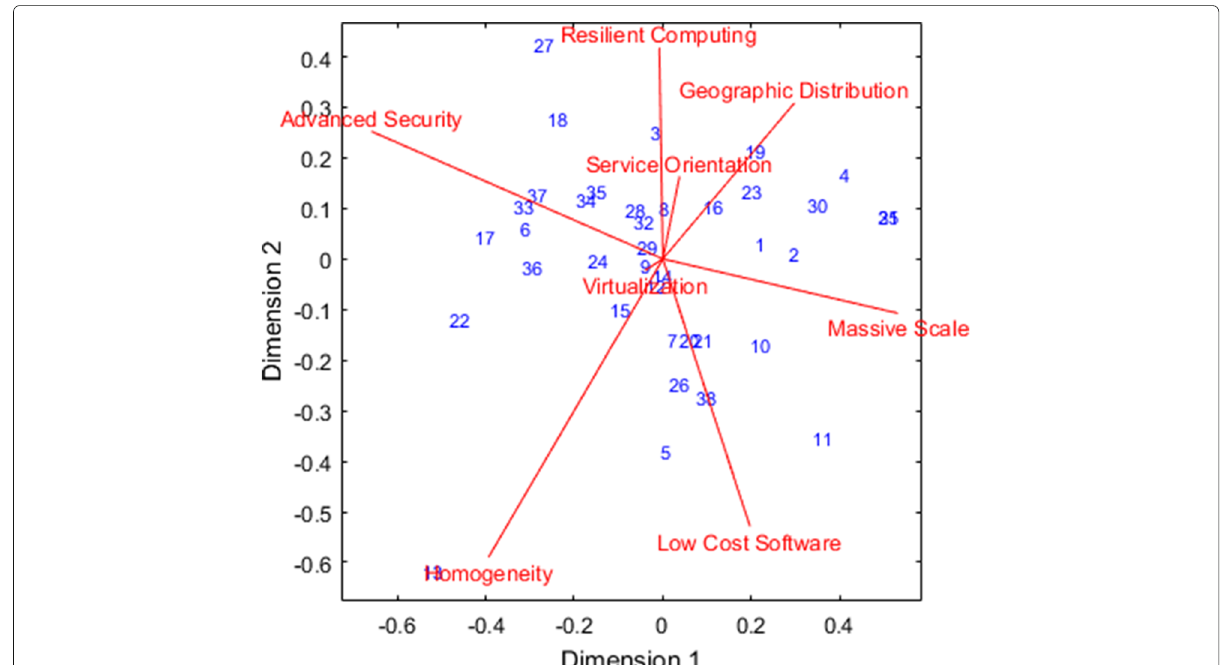
Fig. 8 2-dimensional biplot of the 8-dimensional partitioned dataset of the common characteristics. ServiceOrientation and Virtualisation appear almost insignificant to this solution. There is a roughly even spread of cases, though similar inferences could be made as illustrated in Fig. 1